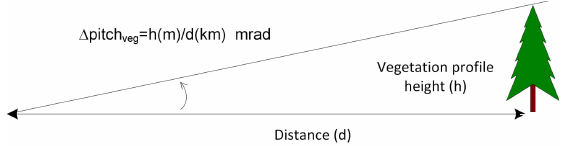
Figure 9. Error due to the presence of vegetation at the sky–terrain